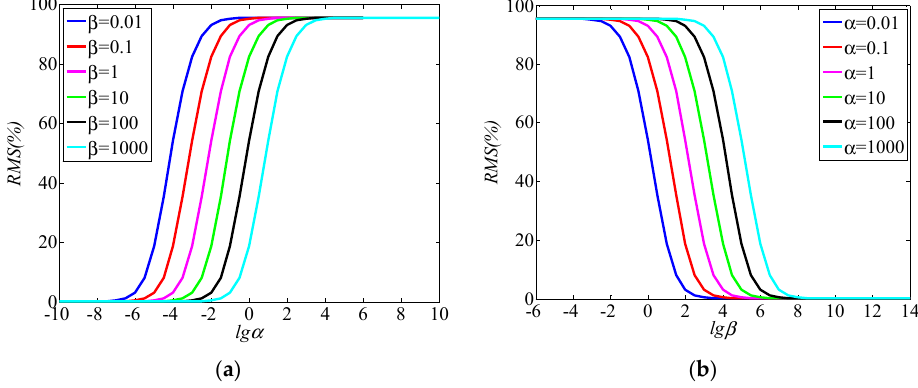
Figure 2. Effect of LQR parameters: ( a ) curves of α ; ( b ) curves of β . Figure 2. E ff ect of LQR parameters: ( a ) curves of α ; ( b ) curves of β